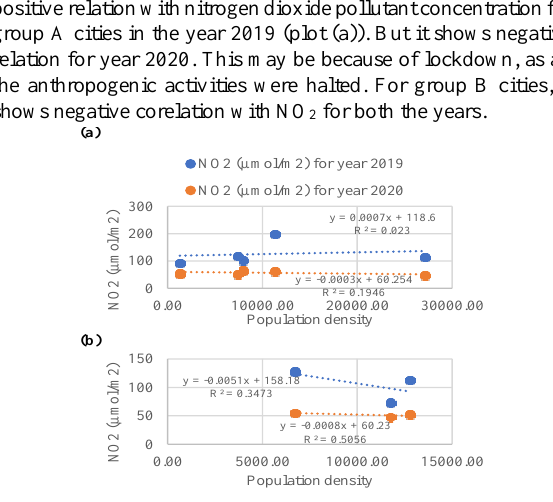
Figure 5. Influence of population density on NO